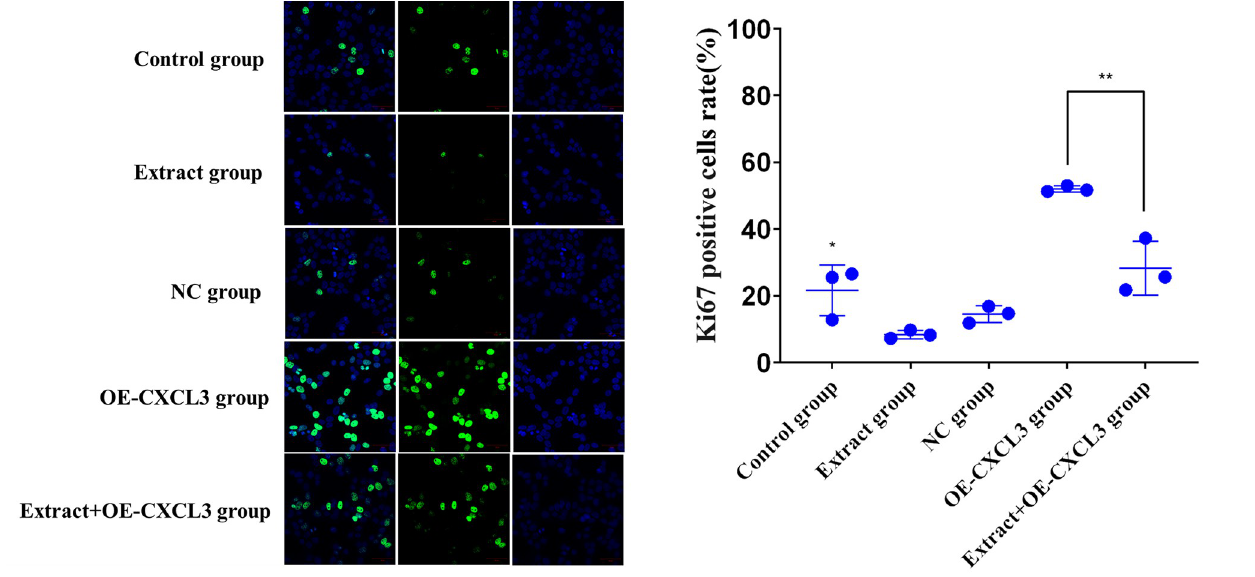
Fig 9. Proliferation of HepG2 cells in control, extract, and transfection groups. ( a ) × 400 magnification fluorescence micrographs of the effects of treatment on HepG2 cell proliferation. ( b ) Ki-67 positive cell rates ( � p < 0.05, �� p < 0.01 compared to the extract group).